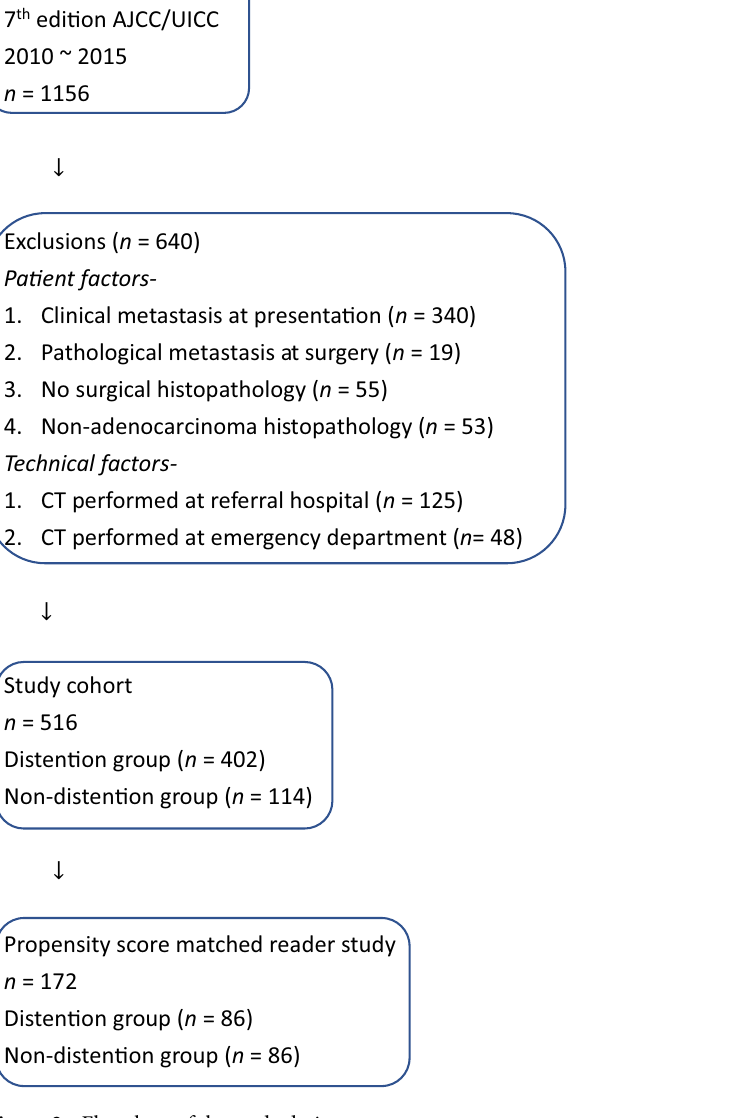
Figure 2. Flowchart of the study